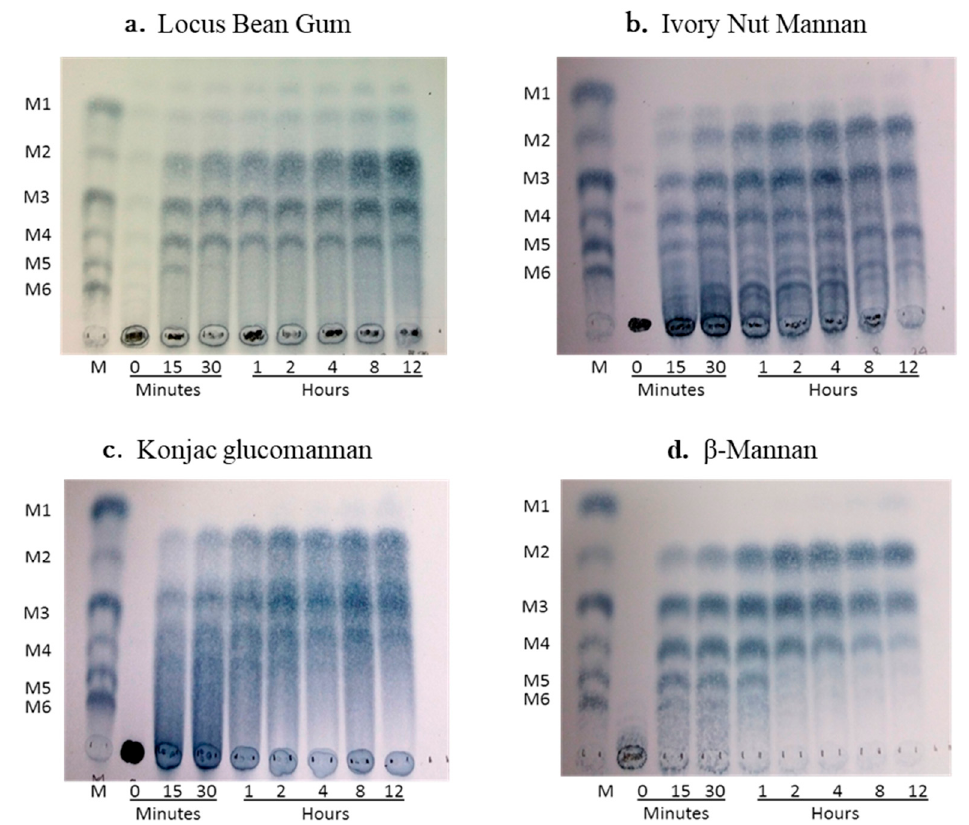
Figure 6. Thin-layer chromatography (TLC) of the hydrolytic products generated by purified ManNj6-379 on commercial substrates: ( a ) locus bean gum, ( b ) ivory nut mannan, ( c ) konjac glucomannan, and ( d ) β -mannan. The reactions in the substrates in 50 mM sodium phosphate buffer (pH 6.0) with 0.1 µ g/ µ L of ManNj6-379 were incubated at 50 ◦ C for 12 h. Four microliters of hydrolysate were spotted on the TLC plate. The incubation time is shown in min and h. The standard was a mixture of mannose and manno-oligosaccharides where M1 is mannose; M2, mannobiose; M3, mannotriose; M4, mannotetraose; M5 mannopentaose; and M6, mannohexaose. Mannobiose (M2) and mannotriose (M3) were the main products of mannan hydrol- ysis, whereas no mannose was detected among the four specific substrate hydrolysates.